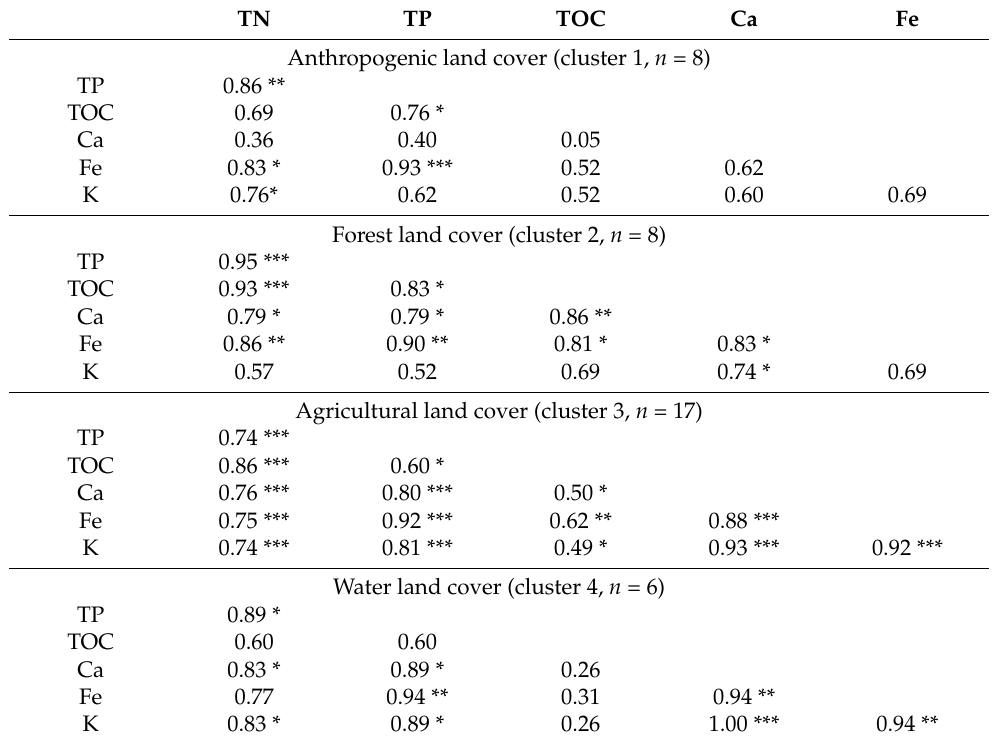
Table A2. The correlation coefficients between the concentrations of elements in the bottom sediments for buffer zones with various land